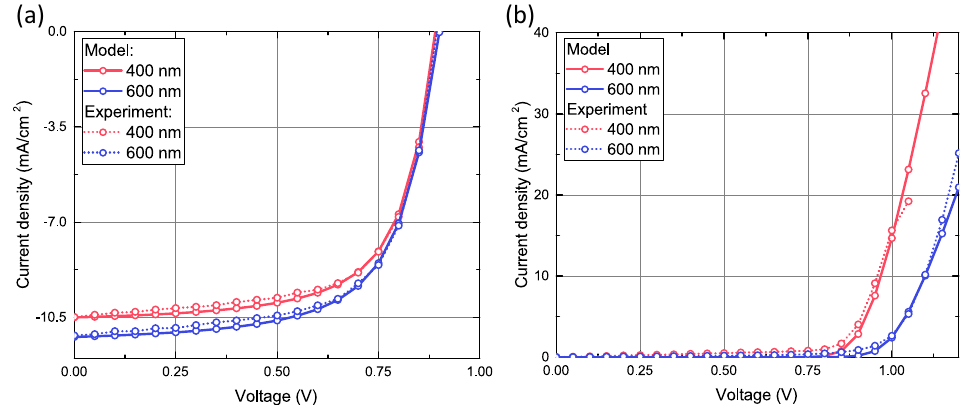
Figure 1. Experimental and modeled I–V characteristics of dual-functional devices with two different thicknesses of perovskite layer: ( a ) 400 nm and ( b ) 600